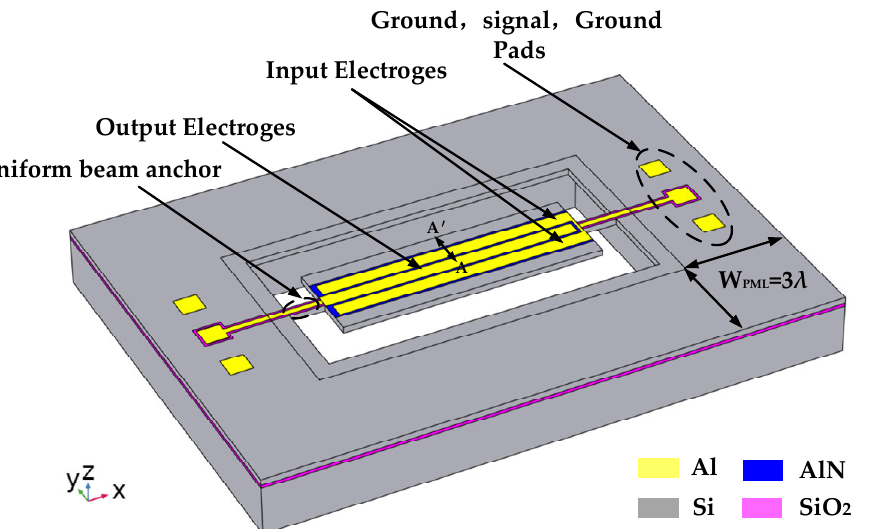
Figure 7. Model diagram of the piezoelectric MEMS resonator designed in this research. Table 3. The specific size parameters of the